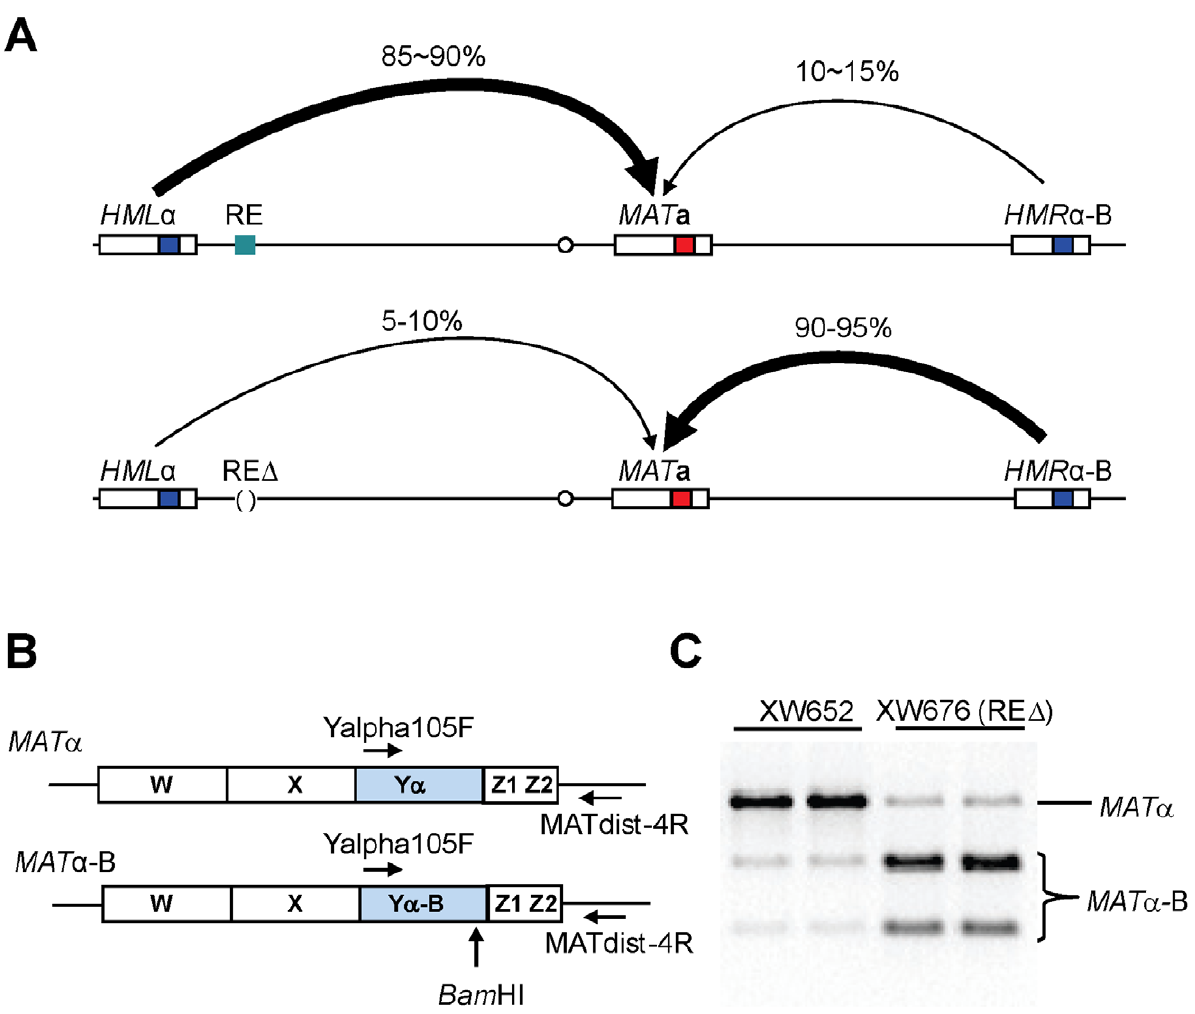
Figure 1. Measure Donor Preference via a PCR-Based Assay. (A) Mating-type switch at the MAT locus. When RE is active in MAT a cells, donor preference ( HML usage) is 85 , 90%. In contrast, HML usage reduces to only 10 , 15% when RE is deleted. Donor preference is calculated using a formula ( MAT a /( MAT a + MAT a - B)). (B) A PCR-based strategy for measuring donor preference. Diagrams are shown for MAT a and MAT a -B. After galactose induction, DSBs at MAT can be repaired using either donor of HML a and HMR a - B. A primer pair (Yalpha105F/MATdist-4R) can only amplify MAT a or MAT a -B, but not HML a , HMR a -B, MAT a due to specificities of these two primers. (C) Measure donor preference via a PCR-based assay. Both MAT a and MAT a - B are PCR-amplified using the primer pair (Yalpha105F/MATdist-4R). The purified PCR products are digested with BamH I and checked on ethidium bromide stained agarose gel. RE is present in XW652, but deleted in XW676.